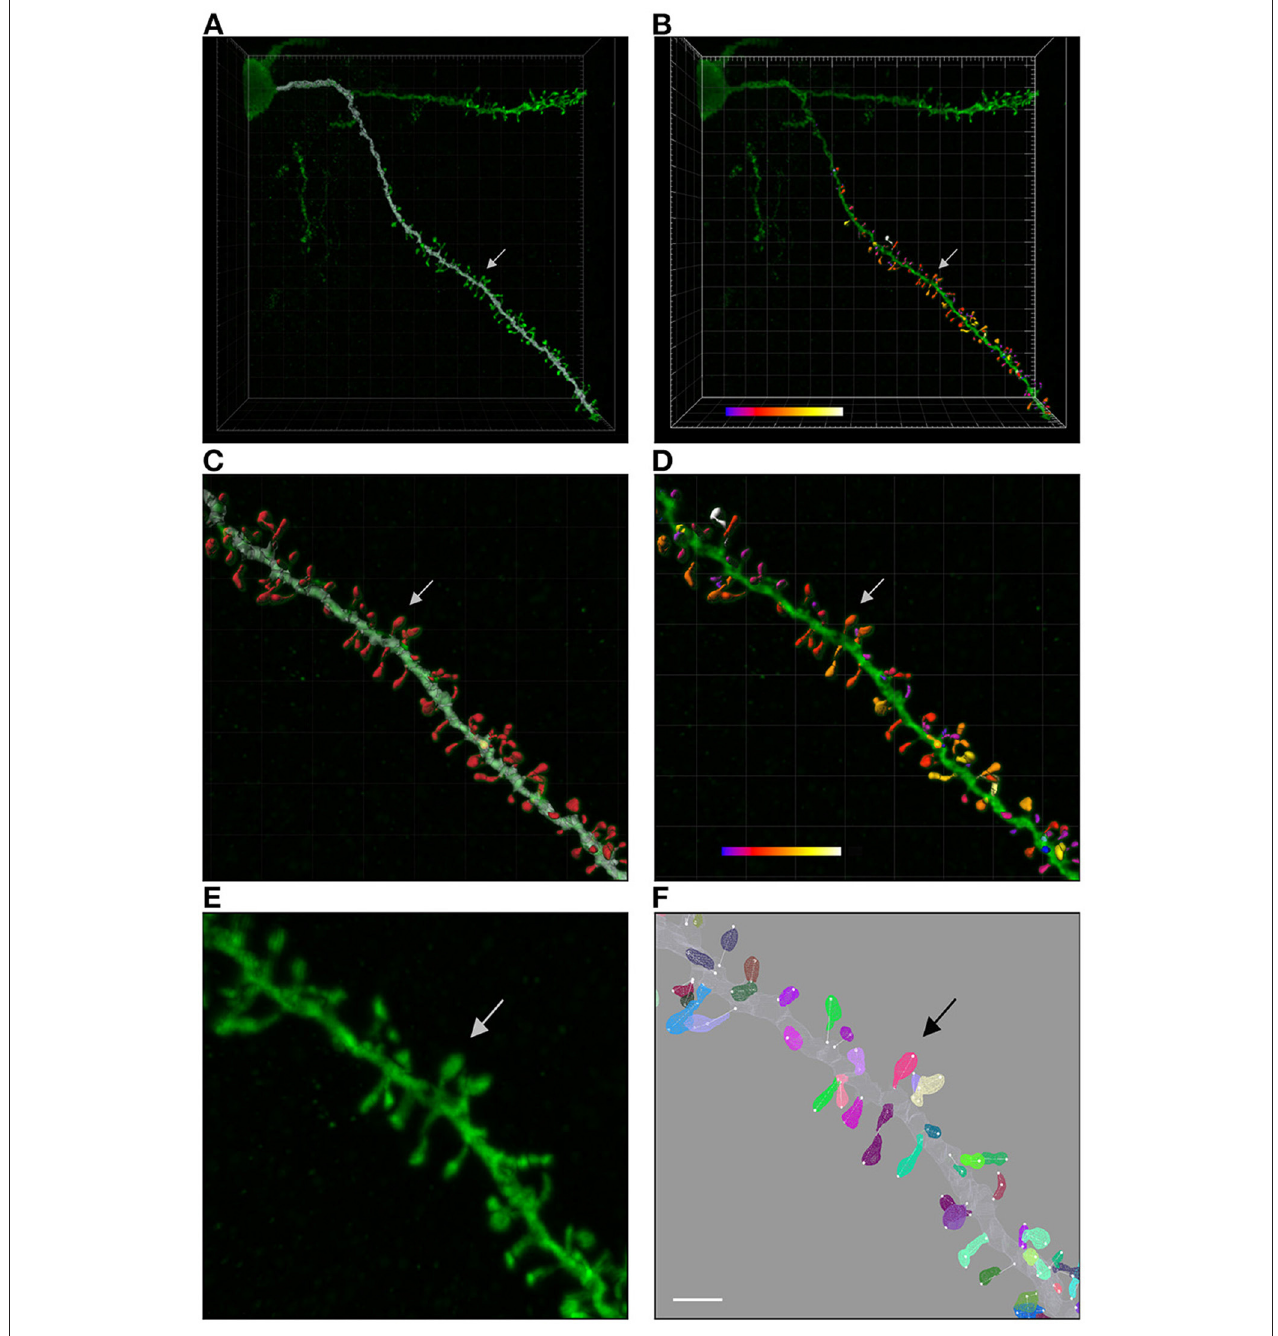
FIGURE 2 | (A) Shows a confocal microscopy image of a proximal basal dendritic segment from an intracellularly injected layer III pyramidal neuron of the human cingulate cortex. Dendritic shaft reconstruction is shown in white. (B) Shows the three-dimensional reconstruction of each dendritic spine from the dendritic segment colored in white in (A) . (C,D) Display higher magnification images of (A,B) , showing the dendritic shaft and spine reconstructions. An estimation of the spine volume values is shown in (B,D) by color codes (blue-white: 0.0–0.899 µ m 3 ). (E,F) Present higher magnification images of the dendritic segment shown in (C,D) . Spines are randomly colored in (F) to clearly visualize the surface meshes that were manually created and assigned to each spine. Spine lengths (white lines) were also measured in 3D. Arrows indicate the same spine in all panels. Scale bar: 10 µ m in (A,B) ; 4 µ m in (C,D) ; and 2.7 µ m in (E,F) .